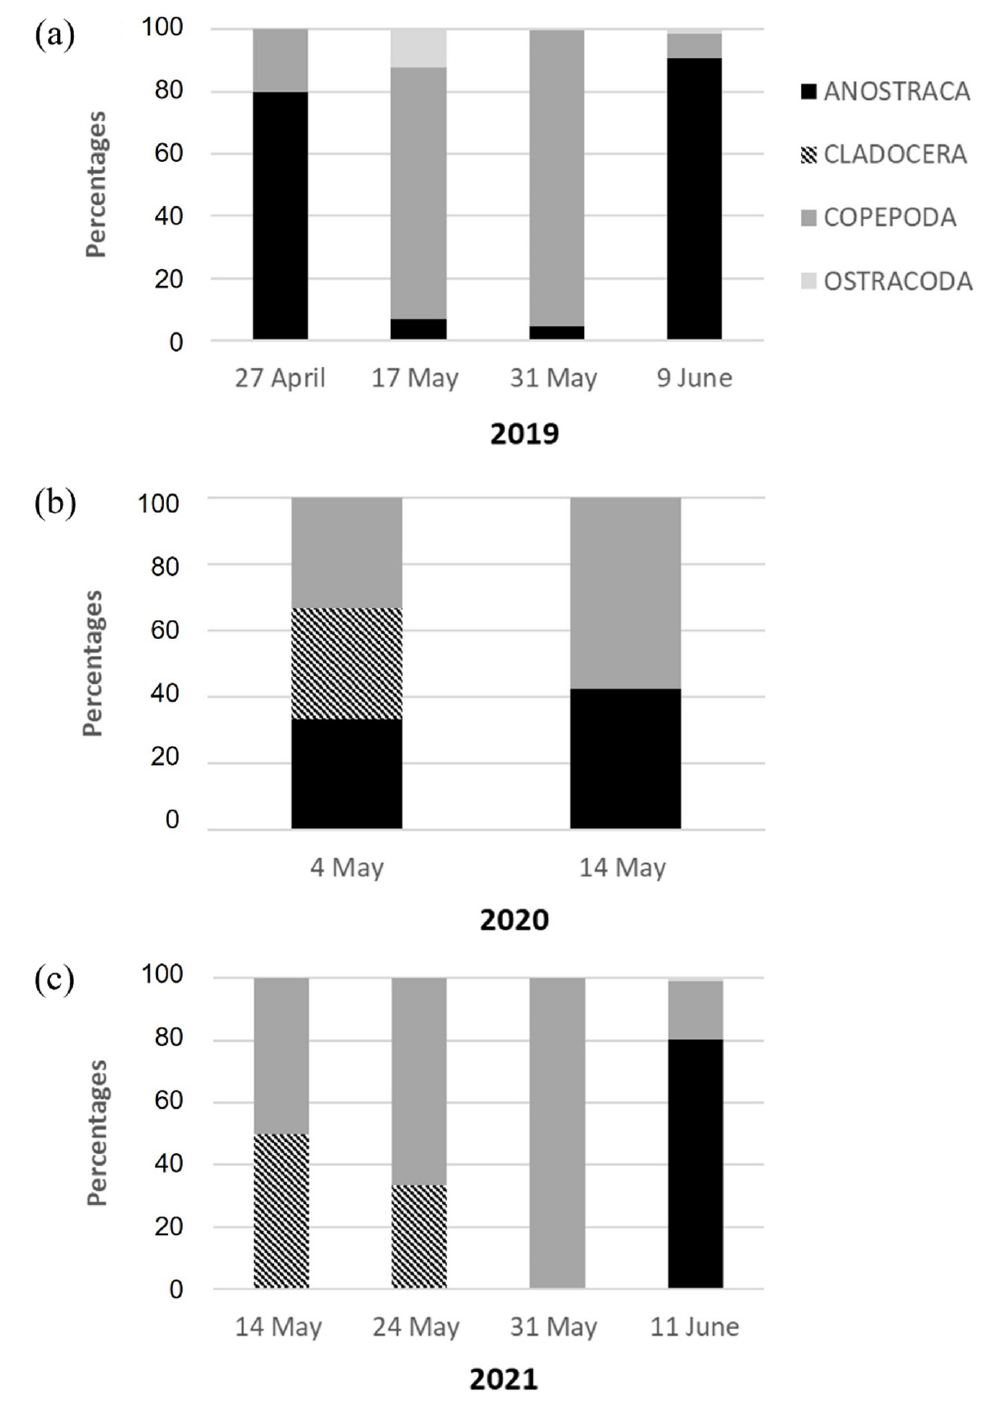
Figure 6. The relative abundance (%) of Anostraca, Cladocera, Copepoda, and Ostracoda in the Palazzo Borghese pond zooplankton community, for the years 2019 ( a ), 2020 ( b ), and 2021 ( c ).